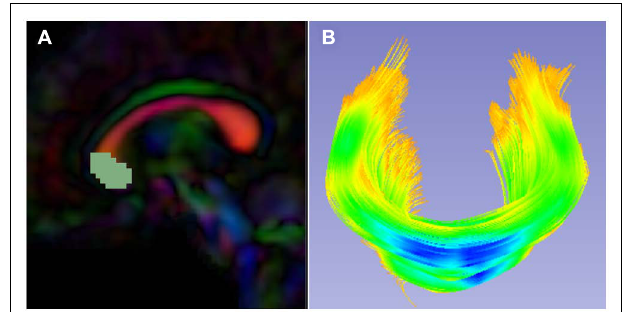
FIGURE 5 | Slicer label map tractography. (A) Sagittal view of the corpus callosum genu label map in the Final DTI Atlas. (B) Resulting genu bundle fibers from label map tractography within 3D Slicer.The bundle is colored by FA values along the fibers with cooler colors indicating higher FA.